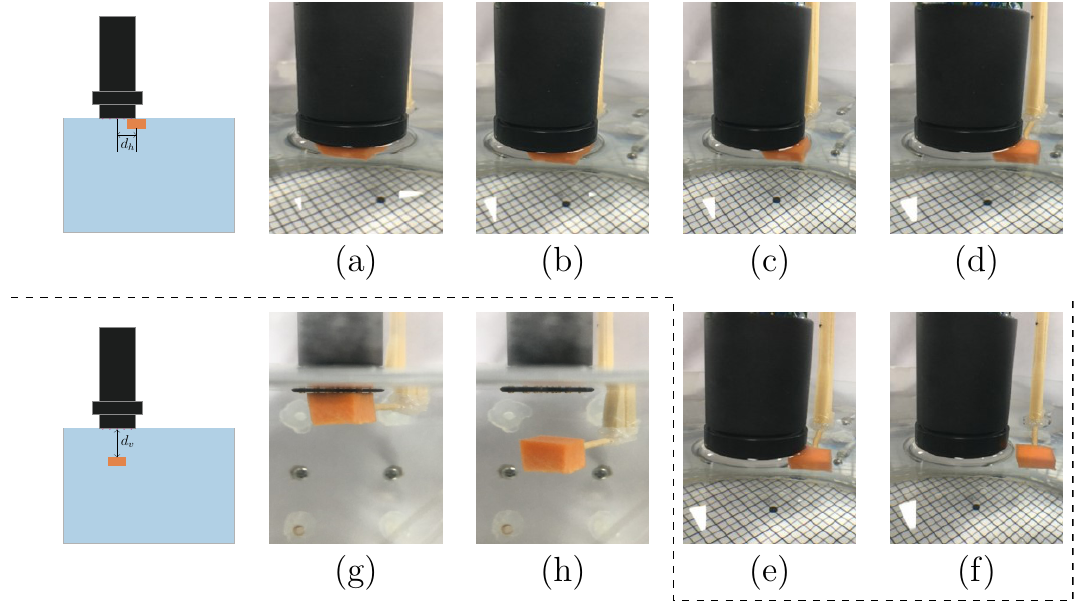
Figure 3. The experimental setup for investigating the sensitivity of probe with respect to the position. ( a – f ) The carrot moves horizontally away from the center of probe d h = 0 mm to d h = 10 mm at 2 mm interval. ( g , h ) The carrot moves vertically away from the center of the probe d v = 0 mm to d v = 4.8 mm at 0.8 mm